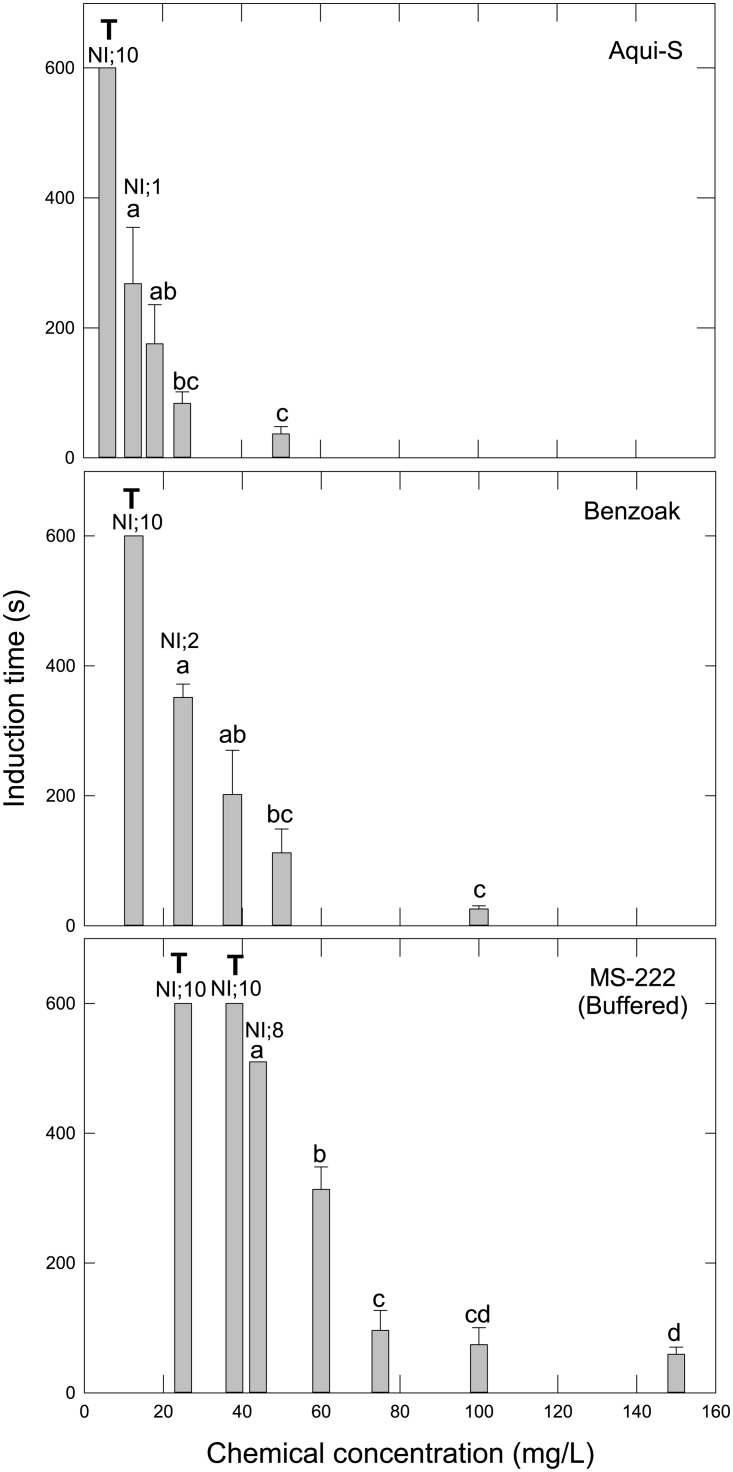
Anaesthetic induction.Time to surgical anaesthesia (stage 3b) for lumpfish fries (Cyclopterus lumpus) subjected to various Aqui-S, Benzoak, and MS-222 concentrations. Values are mean + SD, N = 10 (except MS-222 100mg/L; N = 20). If stage 3b was not reached within 600 sec, the experiment was terminated (T). NI; number of fish Not Induced to stage 3b. Different letters above bars indicate statistical differences.